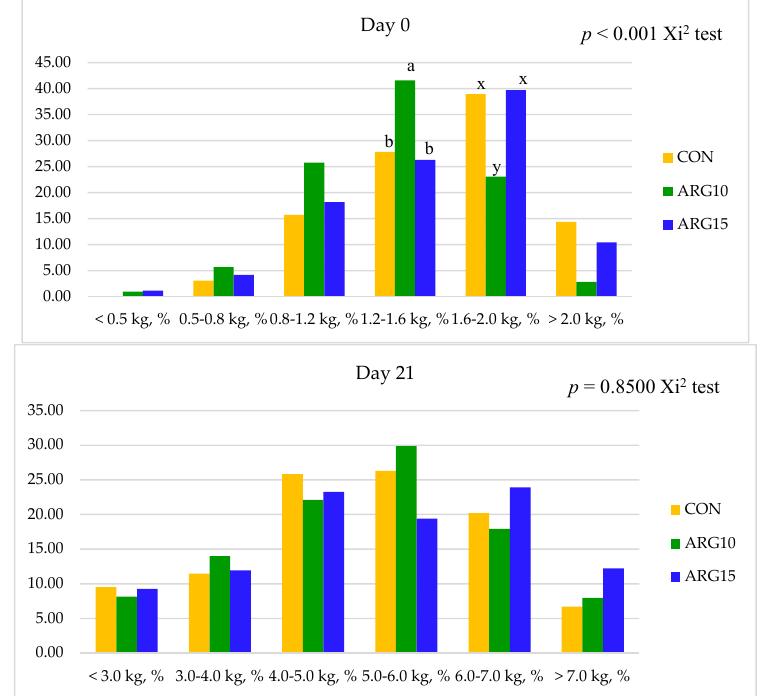
Figure 1. Effect of arginine supplementation level in late gestating sows on piglet distribution into body weight classes on day 0 and day 21 of lactation by the FREQ procedure, with Chi-square test. CON: corn-SBM-based diet with Arg 0.72%, Arg10: corn-SBM-based diet with Arg 1.0%, Arg15: corn-SBM-based diet with Arg1.5%.